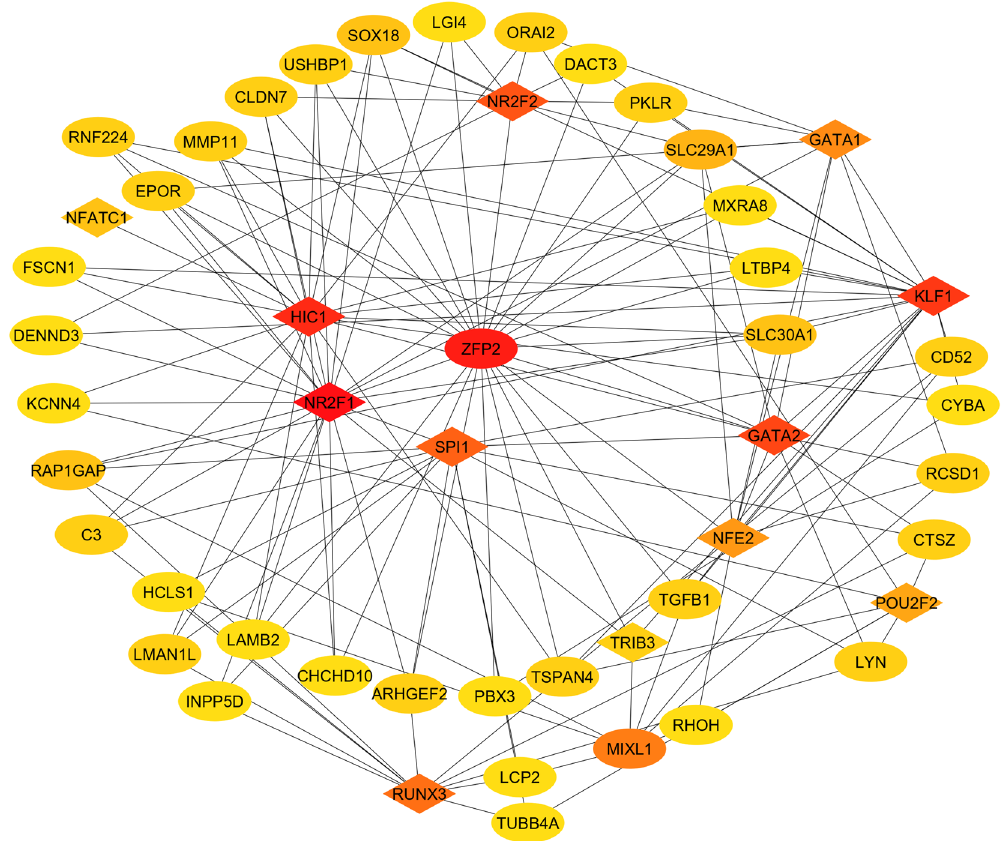
Figure 3. TF-gene regulatory network (developed using ref. 19,20 ). The eclipse in the TF-gene network represented mRNA and the diamonds represented TFs. Color represents degree (red to yellow represent decreasing order of